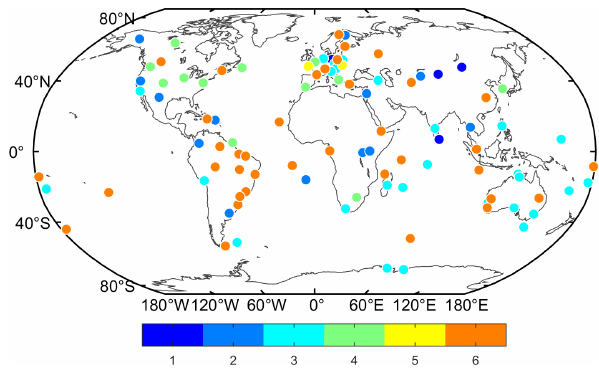
Figure 1. Distribution of selected MGEX stations in January 2019. Six colors represent six different receiver types, which are listed in Table 1.